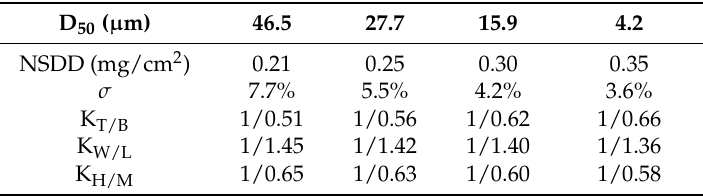
Table 5. K T/B , K W/L , K H/M with different particles